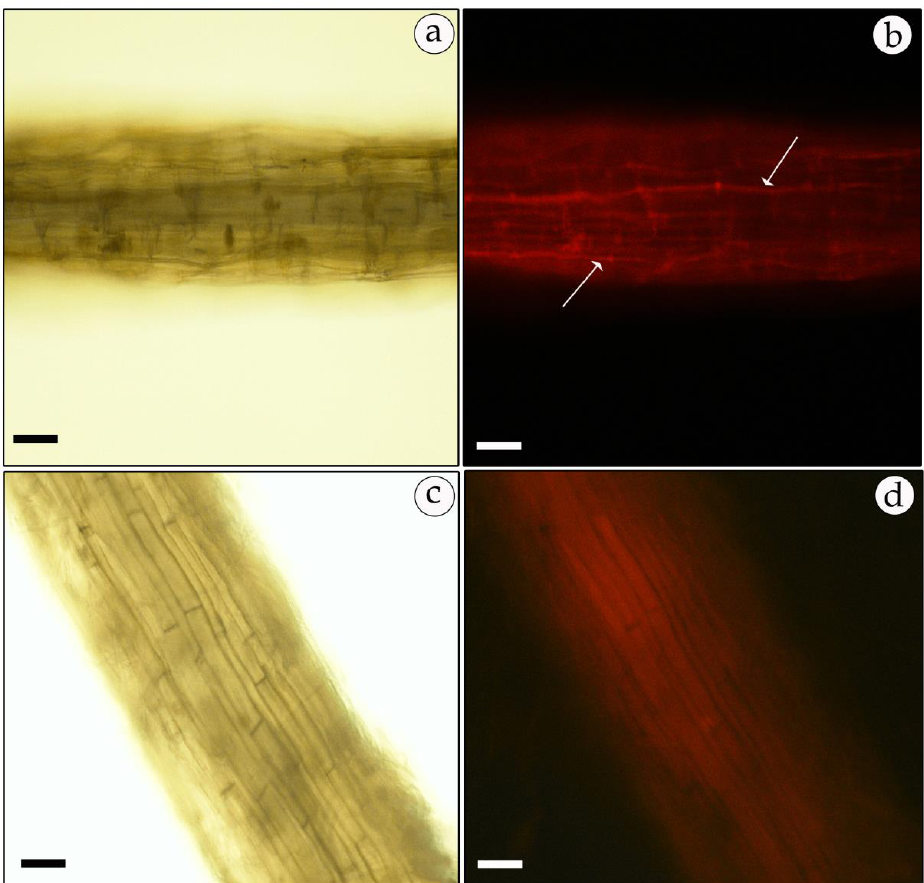
Figure 10. Expression of RFP in T. boudieri hyphae under ectomycorrhizal association with H. sessiliflorum roots. Left panel: bright field of mycorrhized roots ( a ). Right panel: RFP expression in the apoplast of the transformed mycelia under mycorrhiza marked with the white arrow ( b ). Non-transformed mycorrhized mycelia exhibiting diffuse fluorescence background ( c , d ). 200 × magnification. Bar = 20 μm.